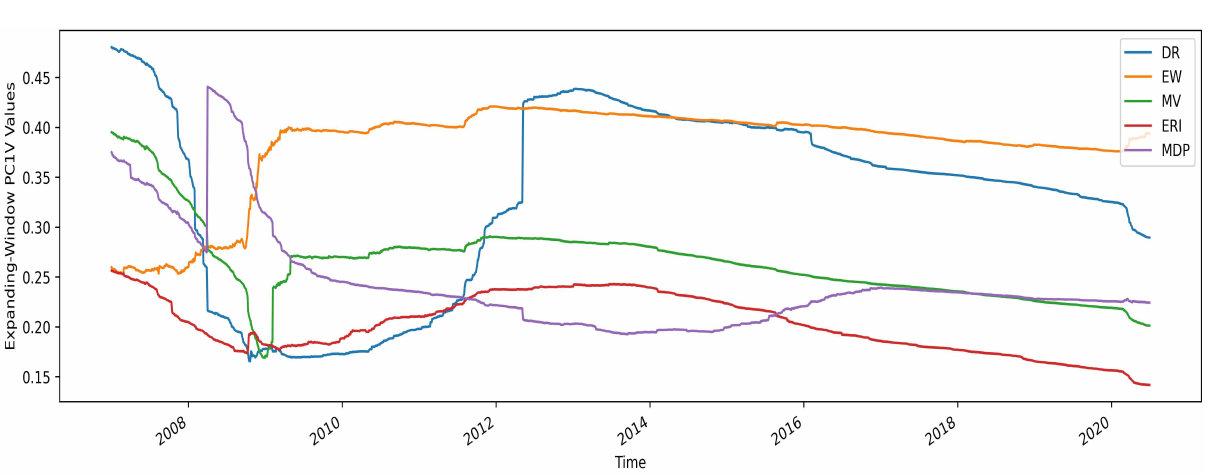
Figure 8. Percentage of variance explained by first principal component for 361-Stock portfolio over the backtest period.